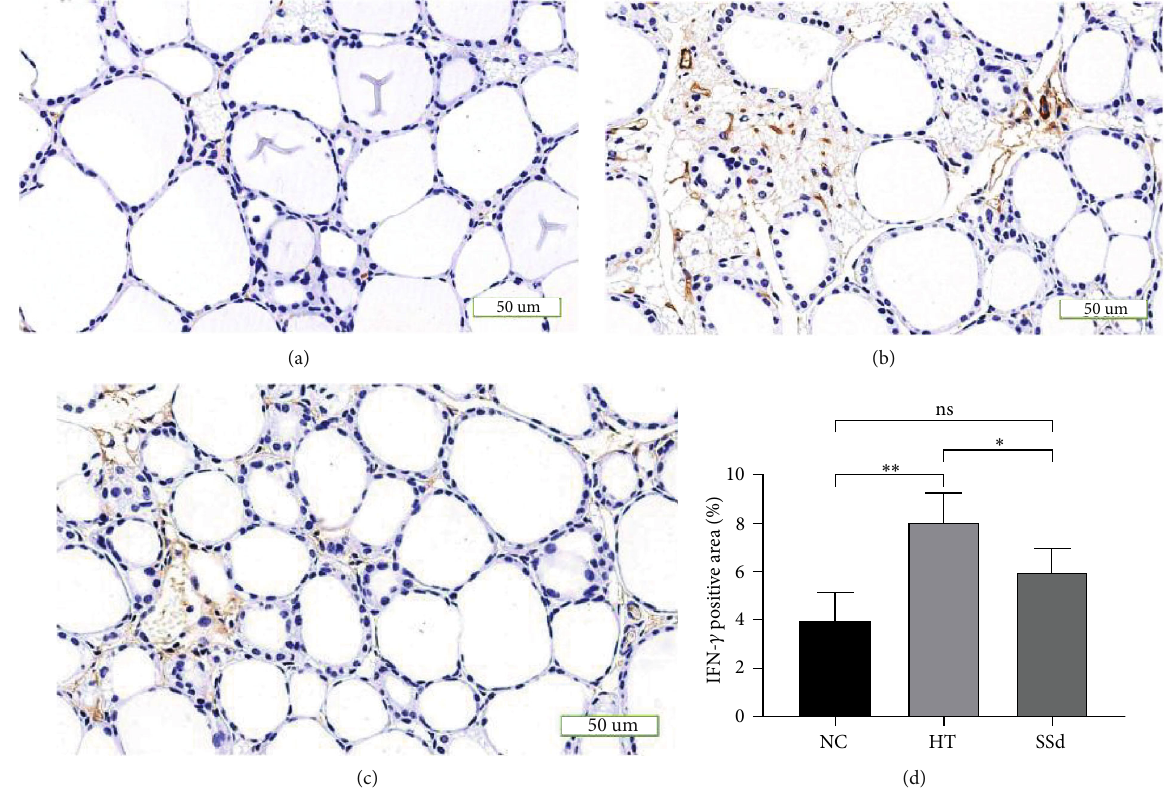
Figure 11: Expression of IFN- γ protein in the mice thyroid. (a) Immunohistochemical staining of thyroid tissue in the NC group of mice (200x). (b) Immunohistochemical staining of thyroid tissue in the HT group of mice (200x). (c) Immunohistochemical staining of thyroid tissue in the SSd group of mice (200x). (d) Comparison of the area (%) positive for IFN- γ protein in mice thyroid tissue ( ∗∗ P < 0 : 01 , ∗ P < 0 : 05